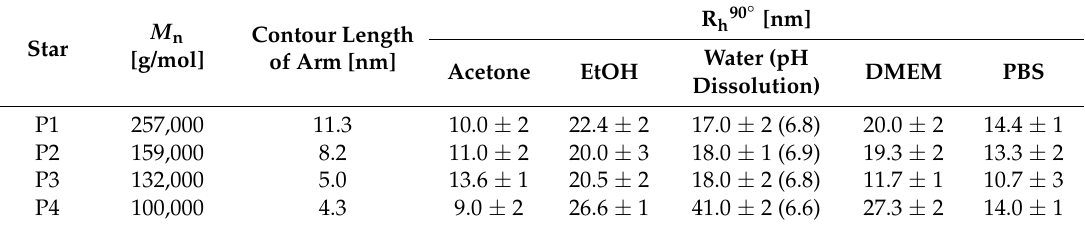
Table 3. Hydrodynamic radii of the P(DMAEMA- co -OEGMA-OH) stars in different